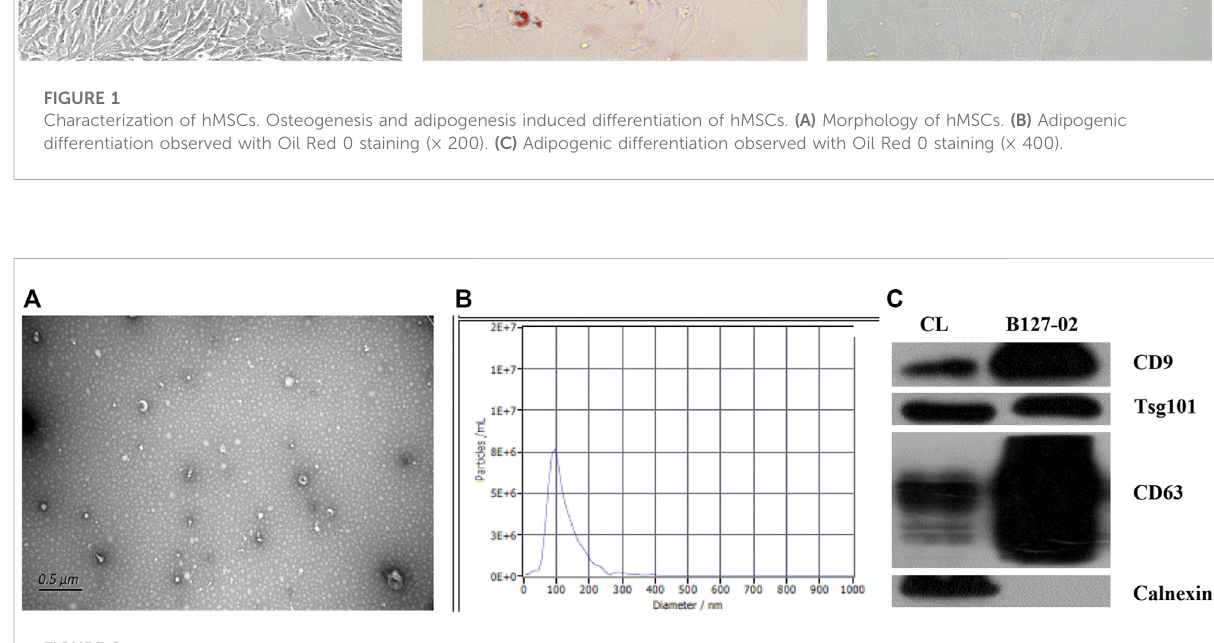
FIGURE 2 Characterization of hMSCs-exosomes. (A) Exosomes under transmission electron microscope (B) Brownian motion based